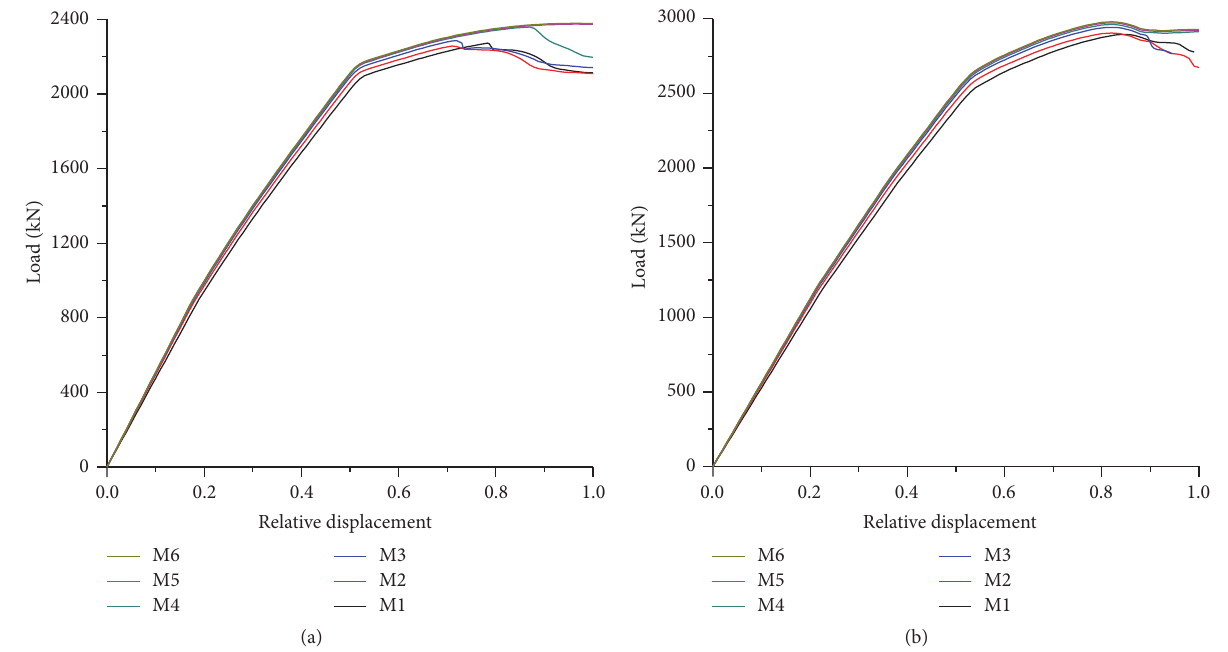
Figure 3: The load curve for different meshes at the (a) age of 3 days and (b) age of 28 days.